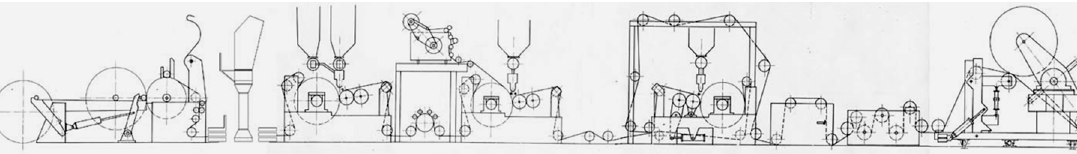
Figure 2. Scheme of a laminator containing around 50 rollers (courtesy of Tetra Pak).